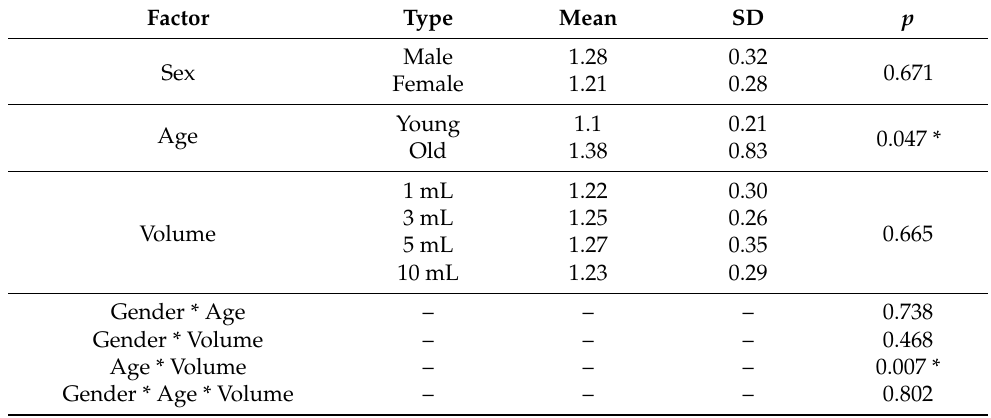
Figure 9. Comparison of surface electromyography (sEMG) onset time T sEMG by ( a ) sex and ( b ) age. Table 5. Analysis of variance results of the factors according to surface electromyography